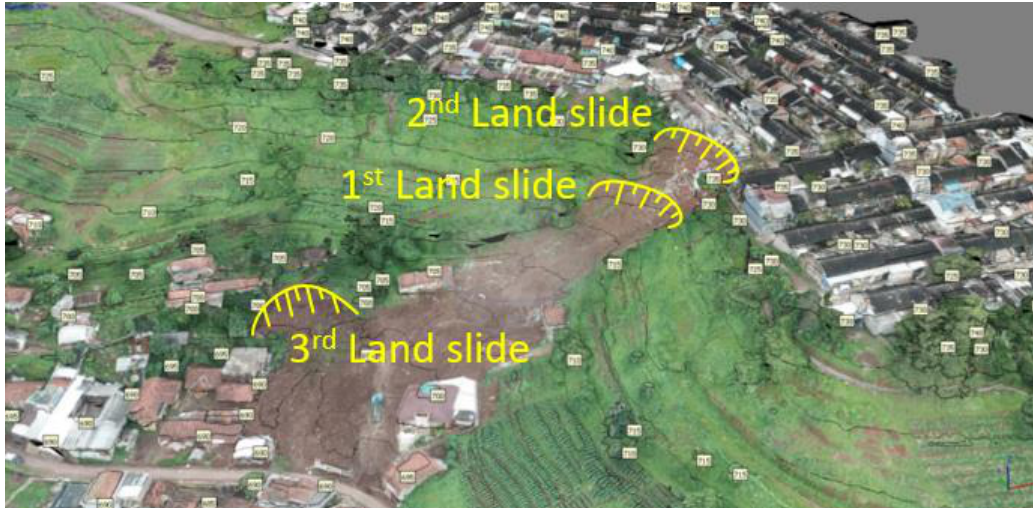
Figure 8. Post-landslide slope contour.